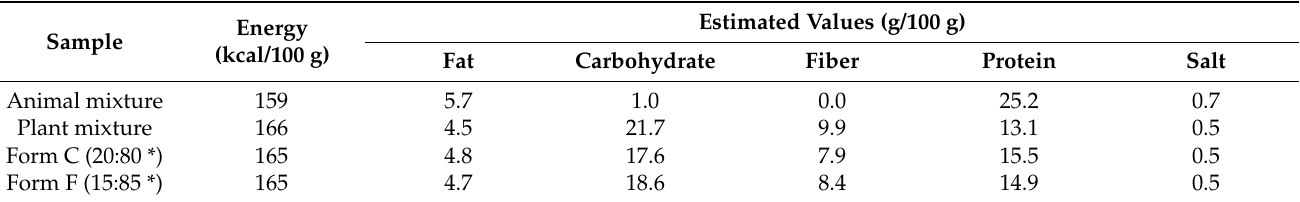
Table 3. Nutritional profile of printable food materials and 3D-printed food products estimated from compositional data and CIQUAL database (wet basis)